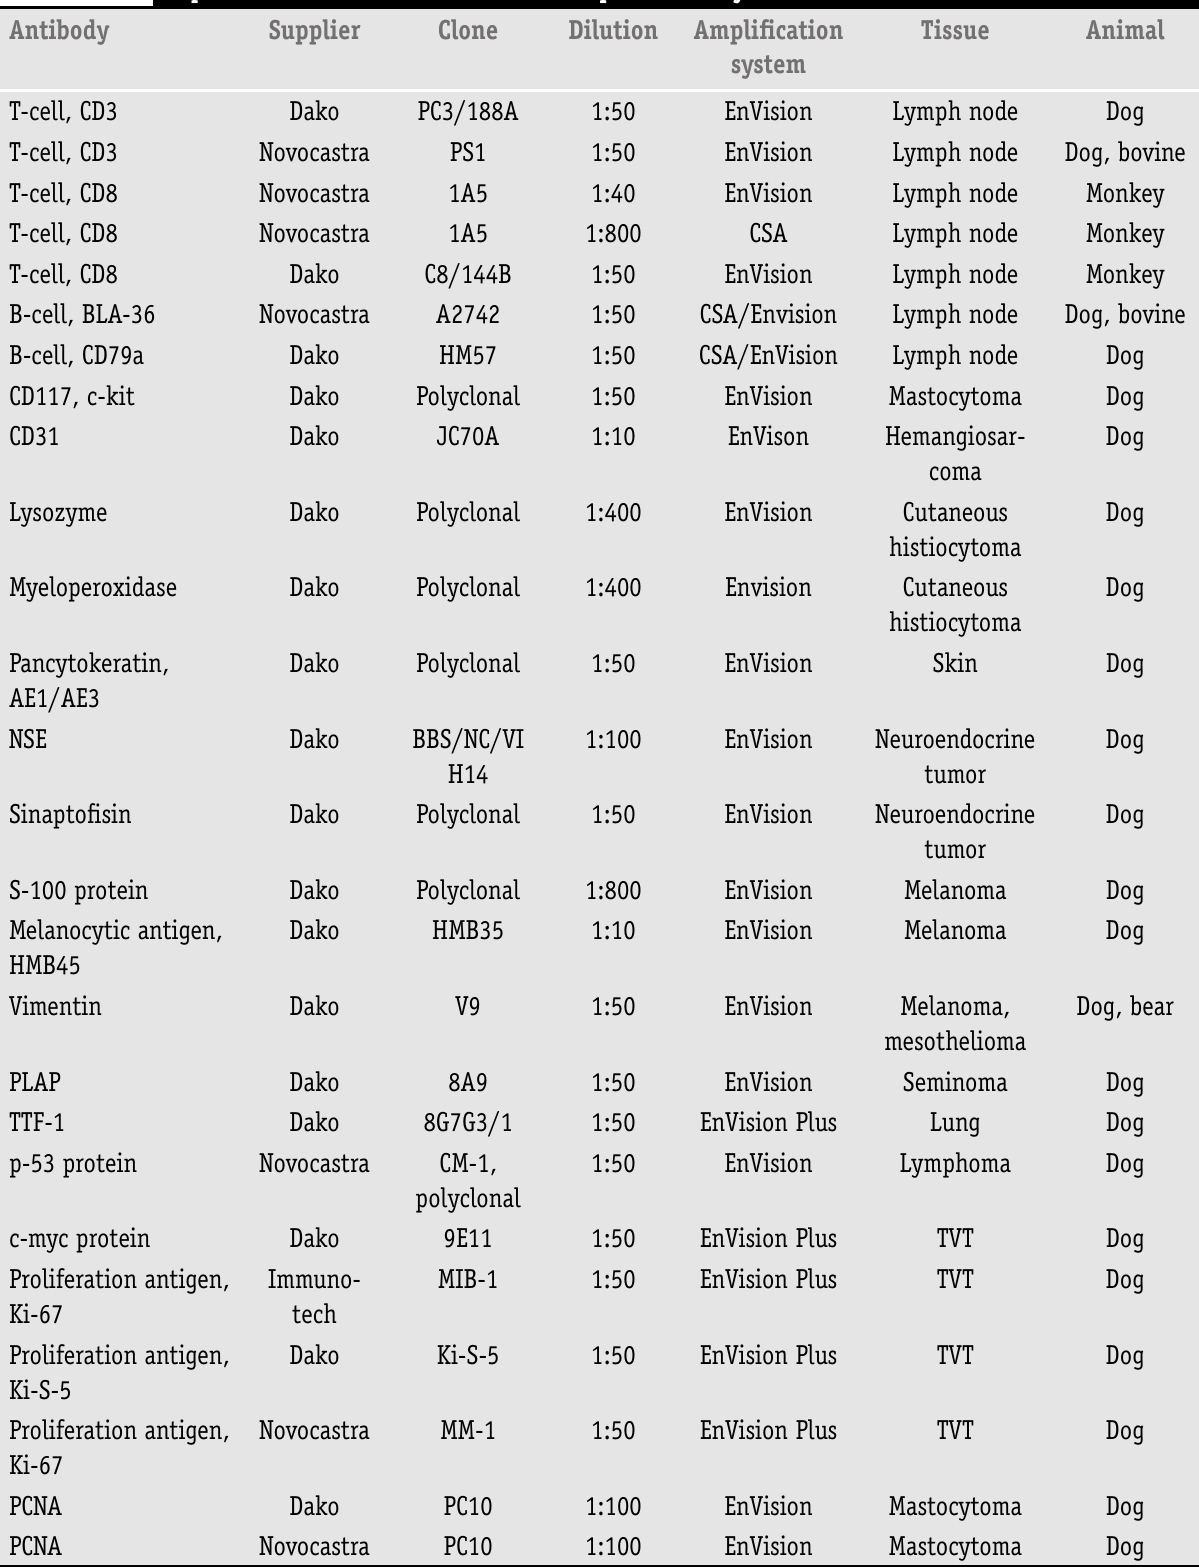
PCNA Novocastra PC10 1:100 EnVision Mastocytoma